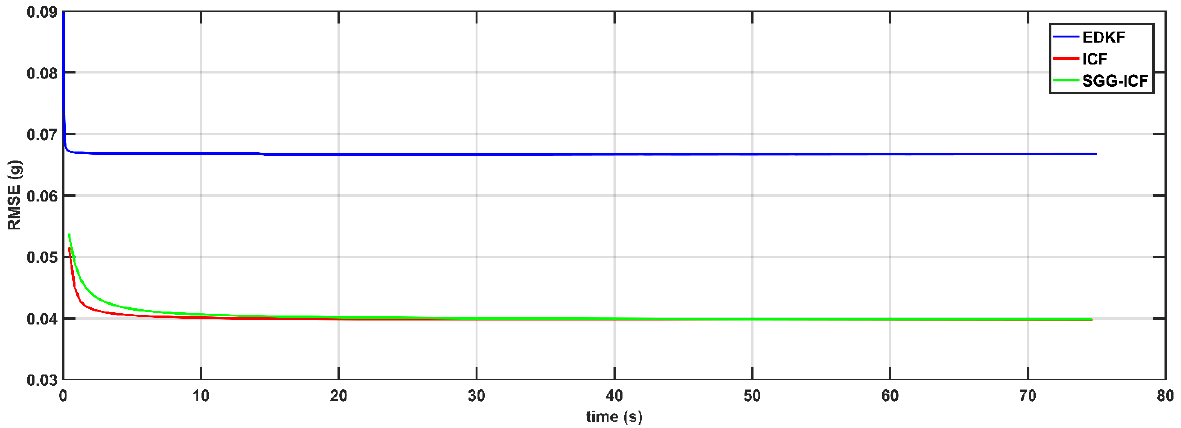
Figure 10. Comparison of RMSE values of sensor node S1 for the selected DKF algorithms.